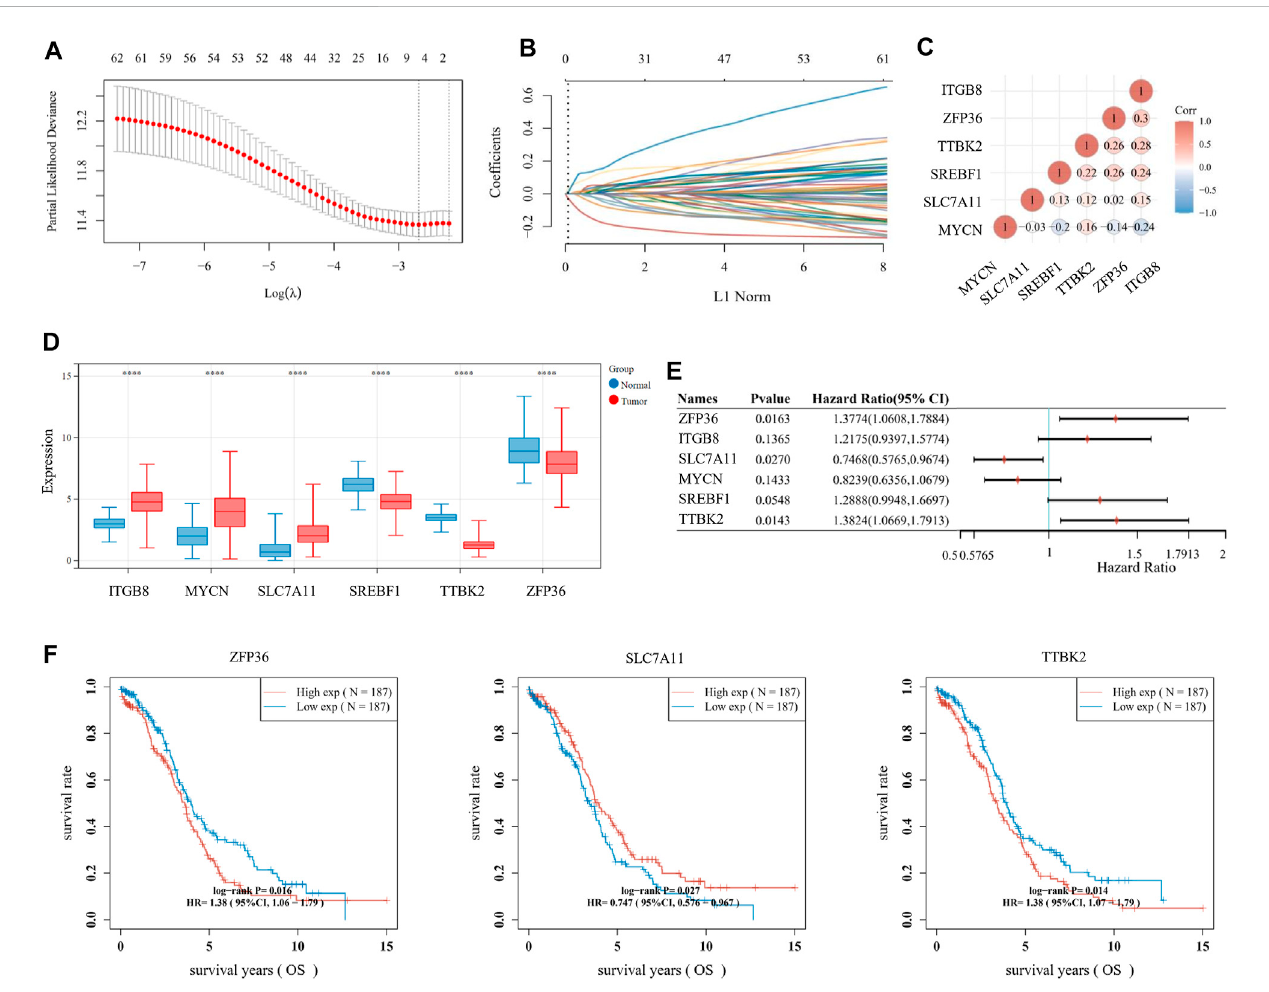
FIGURE 2 Establishment of prognostic signature based on ferroptosis-related genes (FRGs). (A) The λ selection diagram for 10-fold cross-validation of tuning parameter selection in the LASSO model. (B) The LASSO Cox analysis of the optimal prognostic FRGs, including ZFP36, ITGB8, SLC7A11, MYCN, SREBF1, and TTBK2. The coef fi cients of the selected features are shown via the lambda parameter. (C) The expression distribution of the six optimal prognostic FRGs in ovarian cancer (OV) tumor tissues andnormaltissues. (D) Theheatmap ofcorrelationamong thesix optimal prognostic FRGs. The ordinate and abscissa represent genes, while colors represent different correlation coef fi cients (blue for positive correlation and red for negative correlation). (E) The forest plot of theprognosticabilityofthesixoptimalFRLs,analyzed via themultivariateCoxhazardregressionmethod. (F) TheK-MsurvivalcurvesofthreeprognosticFRLs, namely SLC7A11, ZFP36, and